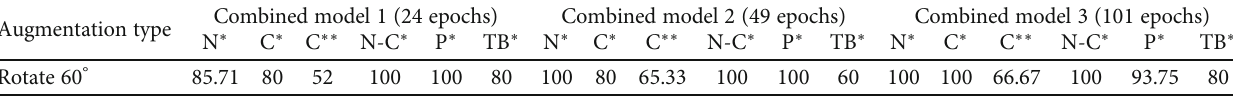
Table 5: Performance of combined models on the testing set of 60 ° rotated